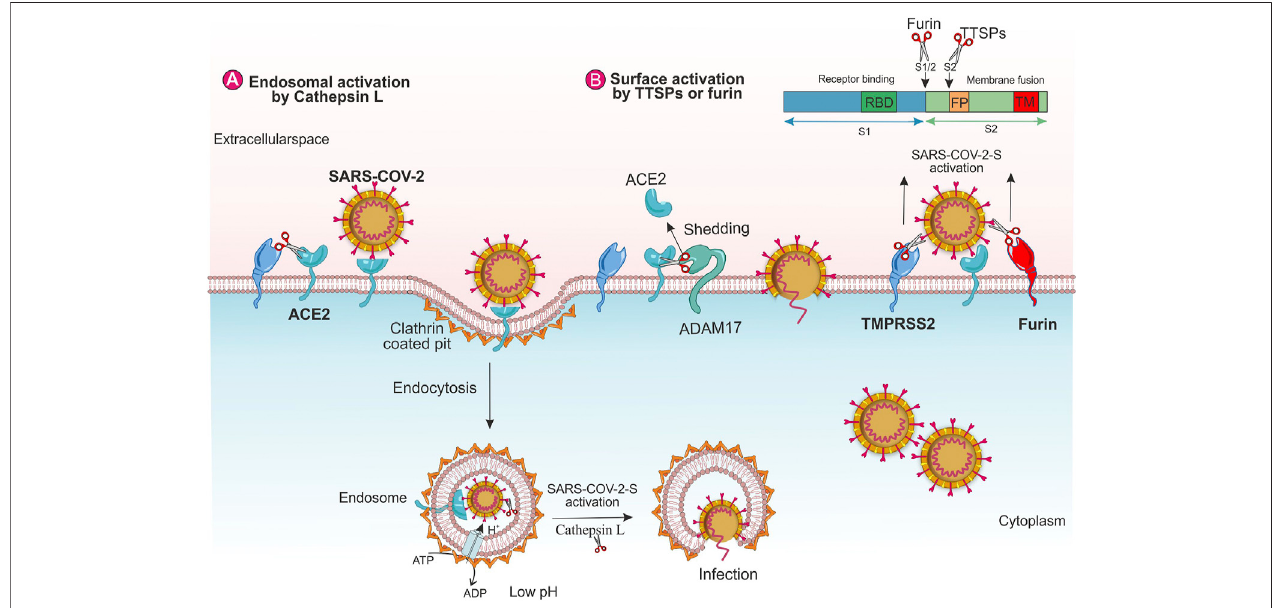
FIGURE 2 | The role of human host proteases on SARS-CoV-2 entry. Virus entry through (A) endosomal pathway and (B) TMPRSS2 and furin.